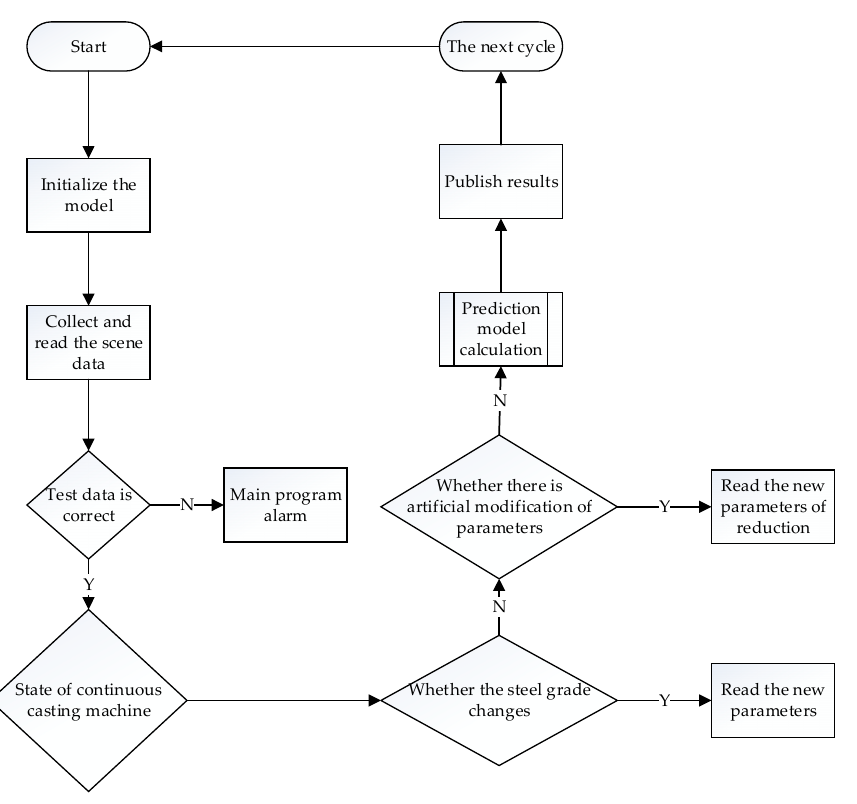
Figure 10. Test system calculation process.